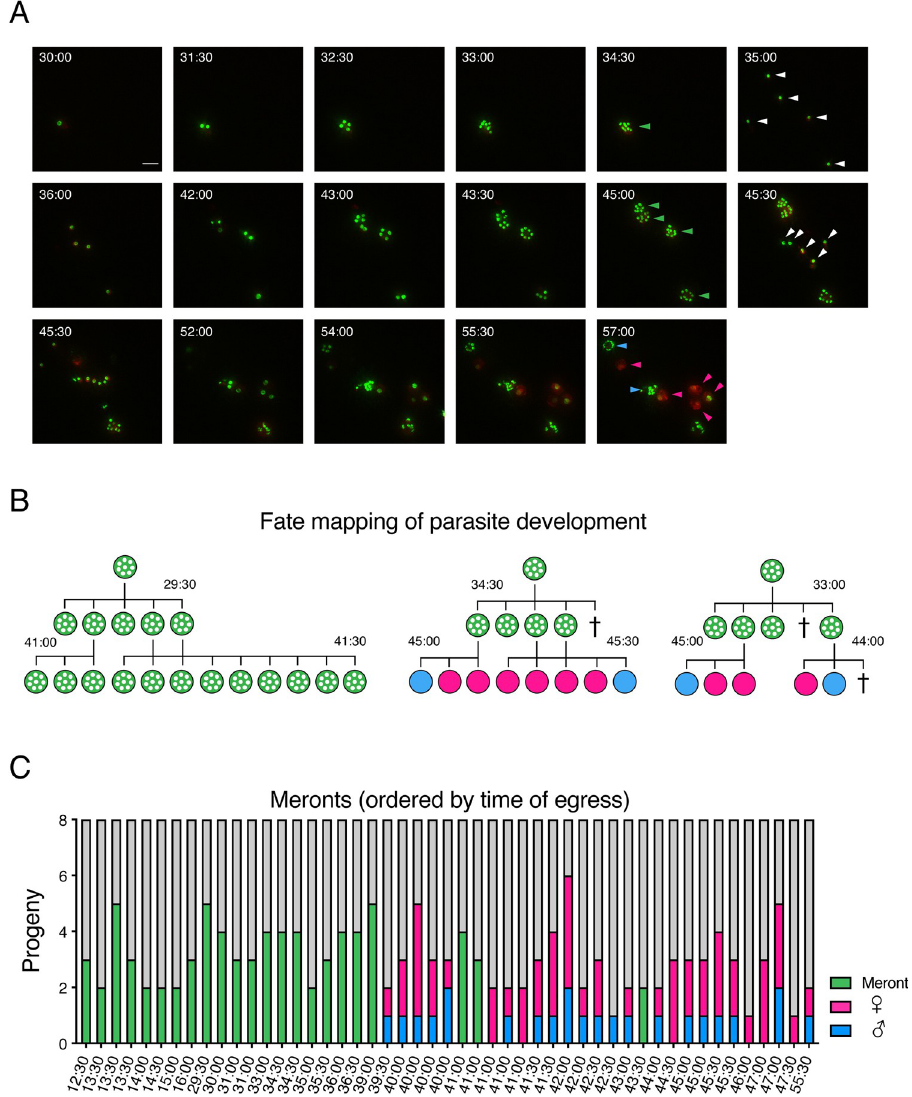
Fig 4. Meronts commit their merozoites to either asexual or sexual fate, but when committed to sex give rise to both males and females. (A) Images taken from time-lapse microscopy depicting multiple generations of parasite replication, including both asexual and sexual stage growth and development. Stills take from video (see S4 Movie) over 27 hours of observation; insets represent hours from time of infection of the culture. Green arrows indicate final fate of asexual meronts, and white arrows indicate newly invaded parasites immediately following an egress event. Blue arrows indicate parasites designated with a male fate, and pink arrows indicate parasites designated with a female fate. Scale bar: 5 μ m. (B) Representative trees depicting the mapped fate of parasites for which the fate of progeny of a single parental meront could be tracked. The tree in the center represents the images seen in (A). Times are shown in hours postinfection. Crosses indicate cells that were lost or died before fate could be assigned. (C) Fate of progeny of single 8N meronts, ordered by time of egress. For each parental meront, the fate of all observable progeny was tracked and is indicated (asexual = green, male = blue, female = pink, and lost to observation or ambiguous = gray). Individual parental meronts are ordered by the time at which the parental meront was last observed. Underlying data are provided in the Supporting information as S3